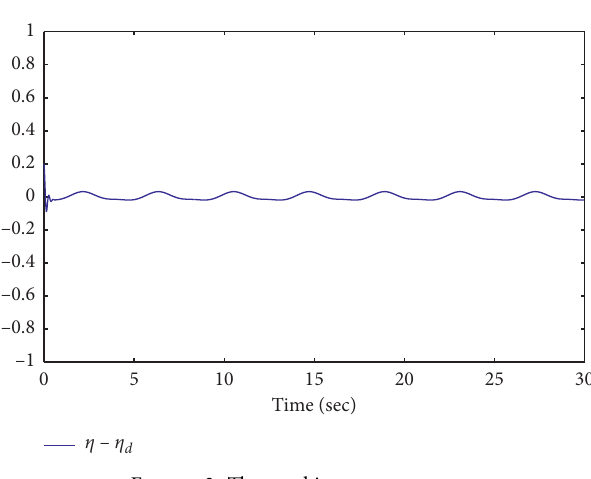
Figure 3: The tracking error η − η